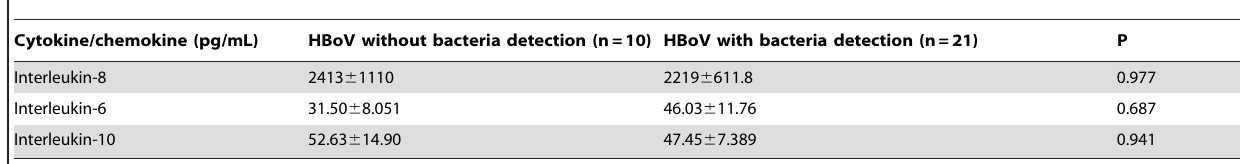
Table 8. Cytokine/chemokine concentrations of respiratory tract aspirates in children who had HBoV detection with or without detection of bacteria.